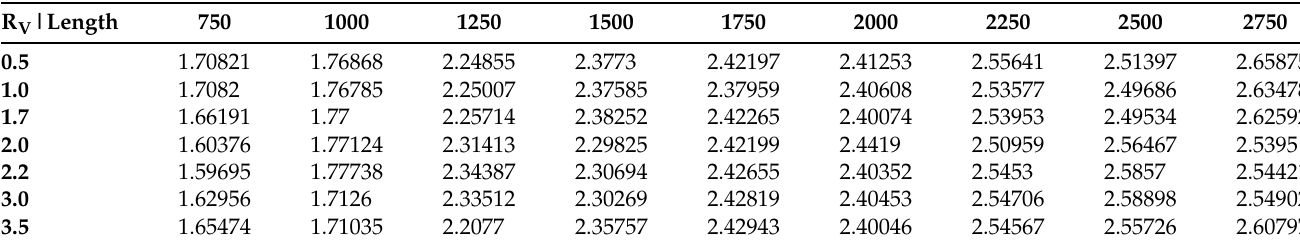
Table A17. Execution times in milliseconds on GPU with ring structure for 40,000 time-steps (2.0 s); R V on the Left and number of cells (length) on the Top .